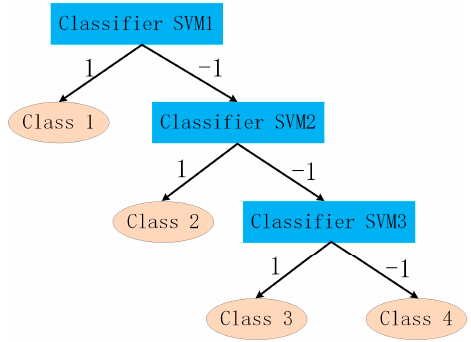
Figure 19. SVM classification model based on binary tree. Class 1: floating discharge; Class 2: surface